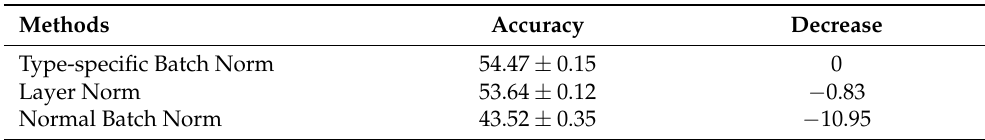
Table 5. Results of ablation study on normalization choices on OGB-MAG dataset. “Normal Batch Norm” means we use the same batch normalization layer for different types of nodes.